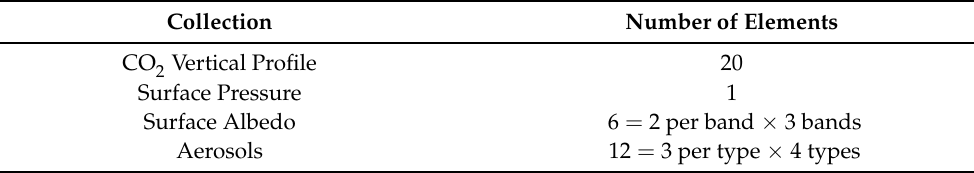
Table 1. Elements of the state vector for the reduced-order model of